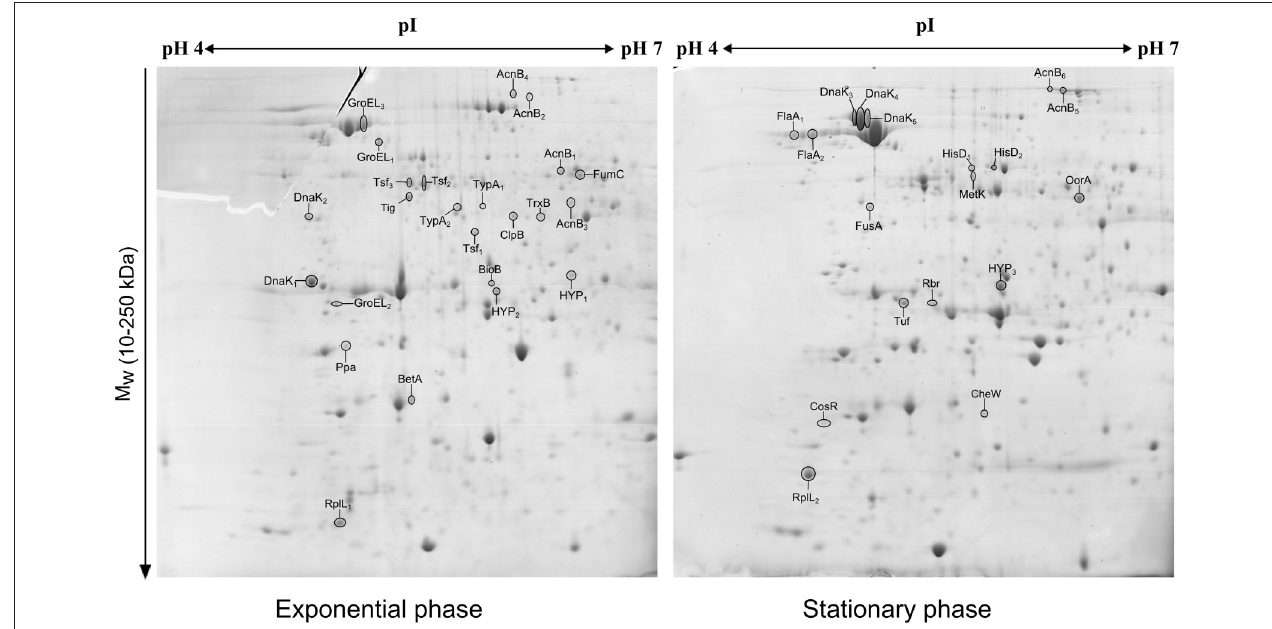
FIGURE 1 | 2D electrophoretic profiles of C. jejuni proteins isolated after 7h (exponential phase) and 16 h (early stationary phase) with highlighted overexpressed proteins. A total of 700 µ g of cytosolic proteins were separated on IPG strip (pH 4-7) followed by second separation by SDS-PAGE in 12% acrylamide gel stained by Coomassie